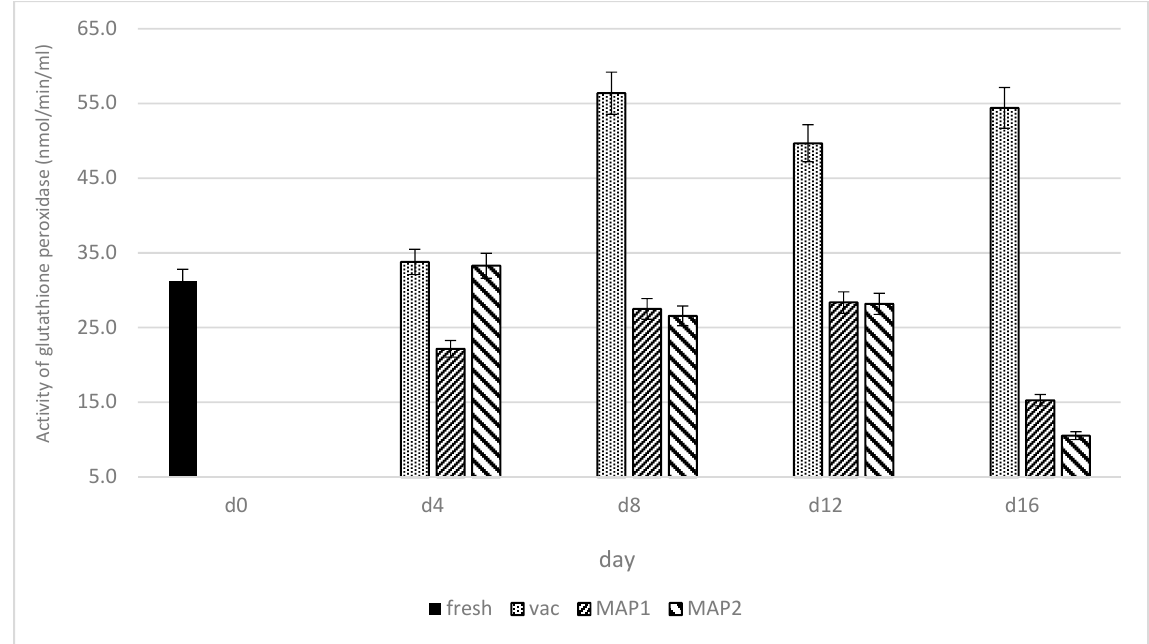
Figure 3. Changes in the activity (nmol/min/mL) of glutathione peroxidase (GPx) in ostrich muscles as influenced by the type of packaging and storage time in refrigeration.